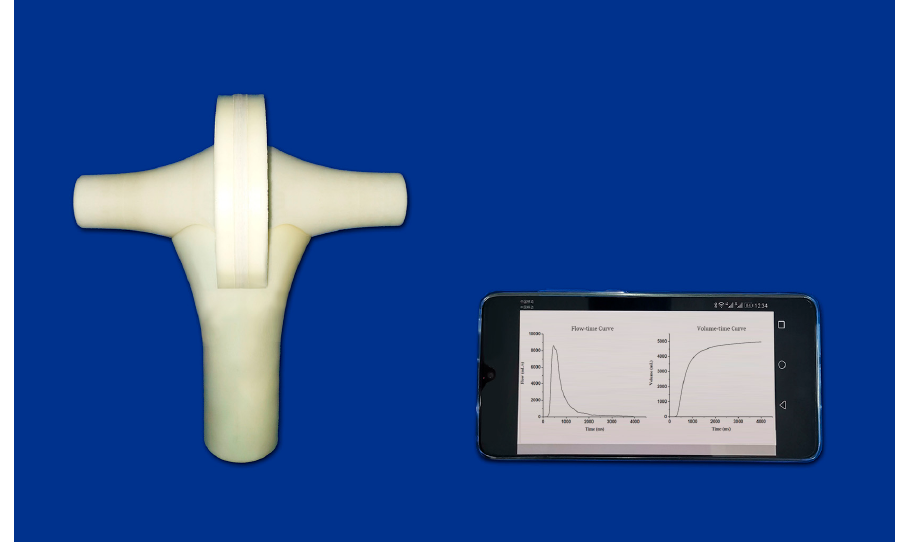
Figure 5. The flowchart of the spirometry app.